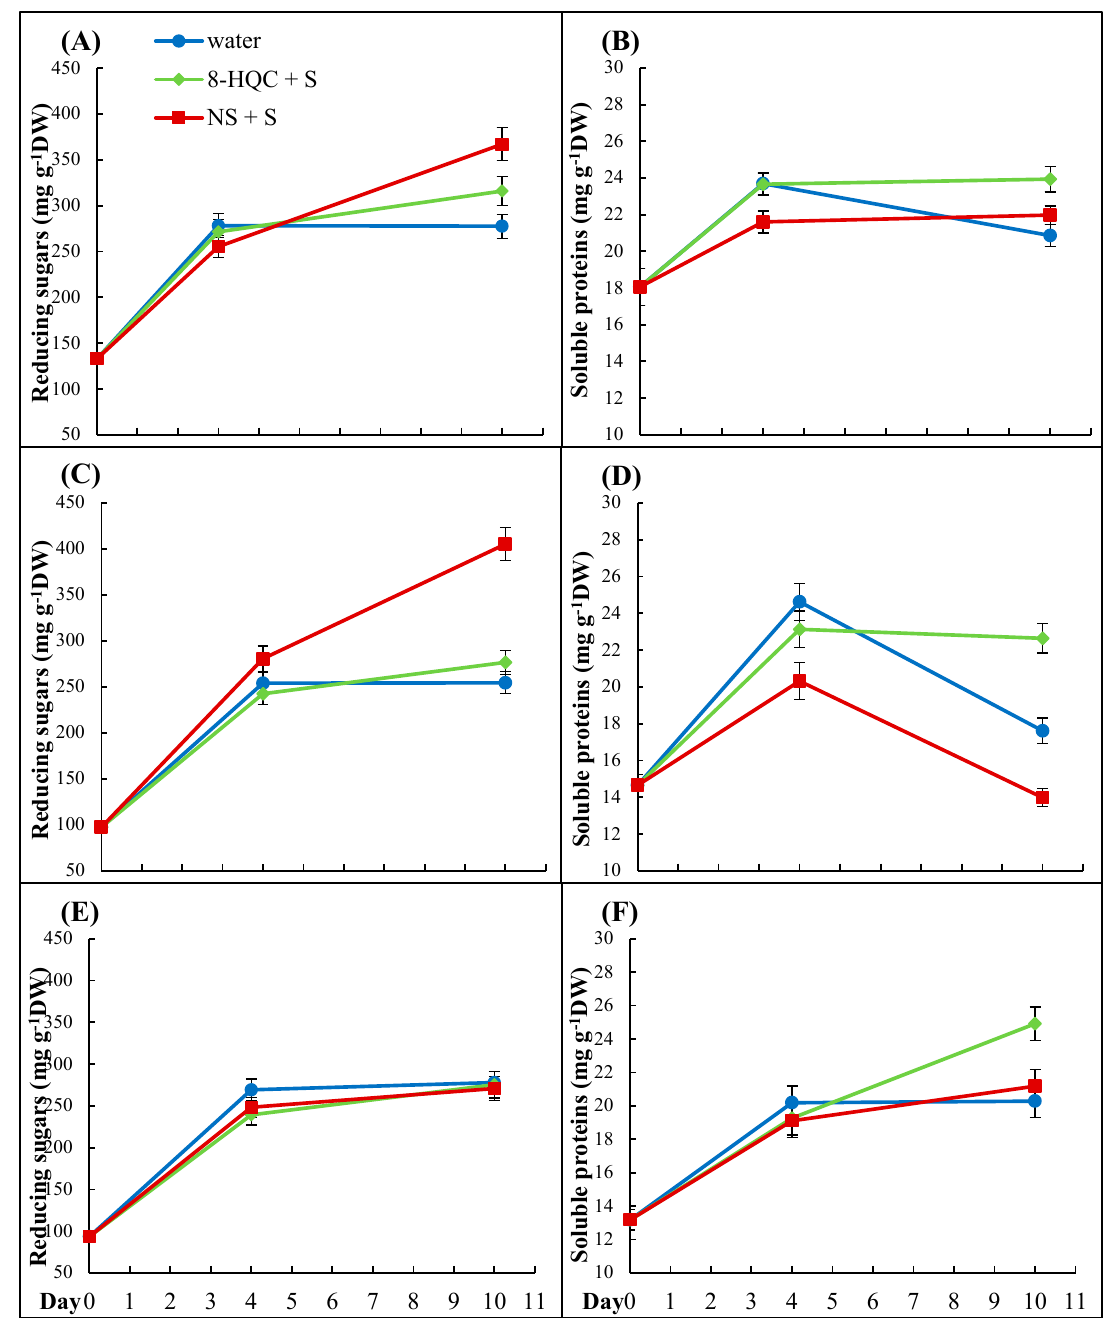
Figure 5. Reducing sugar content ( A , C , E ) and soluble protein content ( B , D , F ) in cut flowers of peony ‘Charles Binder’ ( A , B ), ‘Festiva Maxima’ ( C , D ), and ‘Gayborder June’ ( E , F ). Values are expressed as the mean ± SD. Vertical bars represent standard deviations of the means.